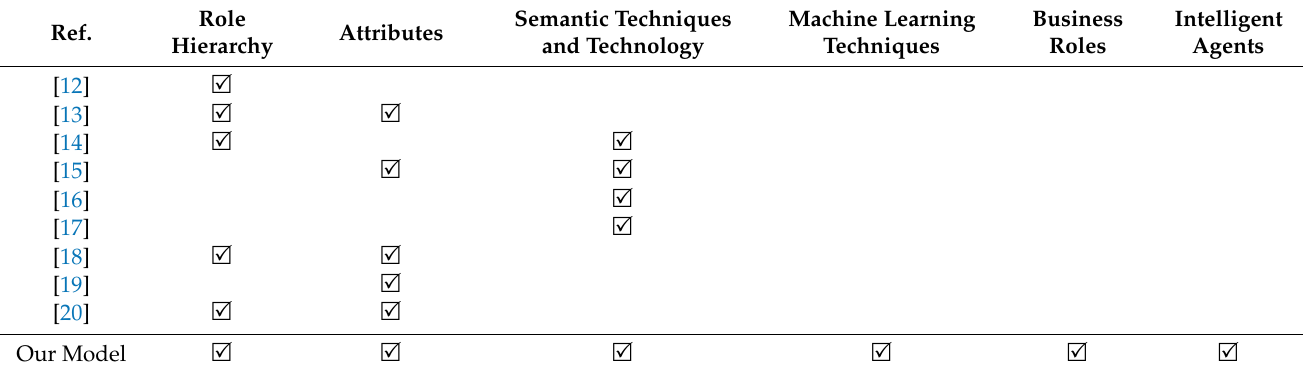
Table 1. Comparison of our I-RBAC model with existing extended RBAC models for multi-domain collaboration.